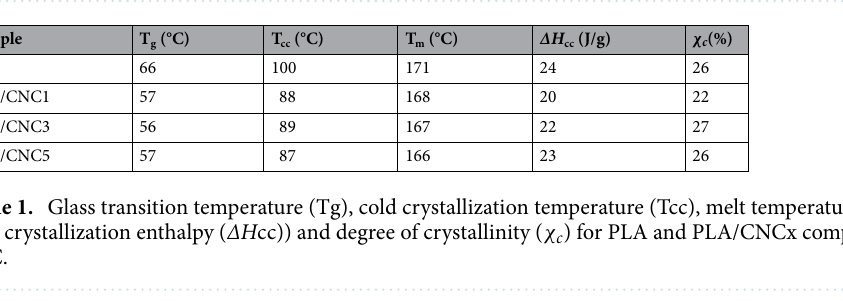
Figure 2. Thermal analysis of PLA and PLA/CNCx extruded filaments. ( a ) thermogravimetric analysis (TGA, under nitrogen from room temperature to 800 °C at a heating rate of 10 °C min −1 ), ( b ) derivative TGA (DTG) and ( c ) differential scanning calorimetry (DSC curves, from room temperature to 250 °C with a heating rate of 20 °C min −1 under nitrogen atmosphere) showing the T g , T cc and T m of PLA and the nanocomposites.